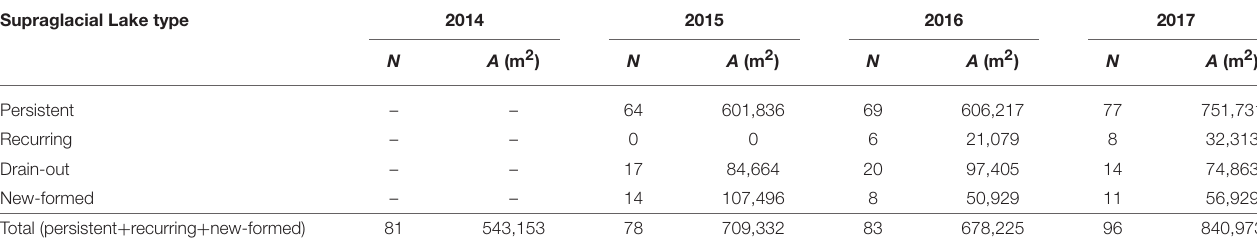
TABLE 4 | Statistics ( N = number, A = area) of supraglacial lakes (SGL) during 2014, 2015, 2016, and 2017 in the study area (i.e., Sikkim Himalaya). Supraglacial Lake